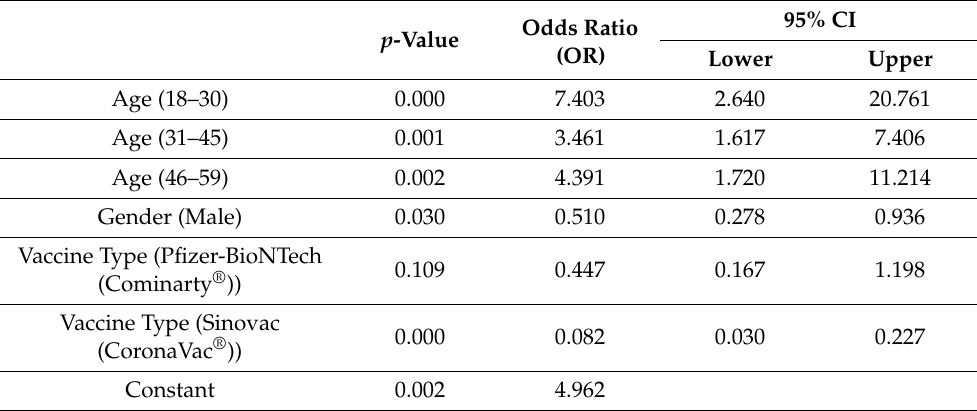
Table 4. Binomial logistic regression of the impact of age, gender, and the type of received vaccine on the risk of experiencing vaccine-related side